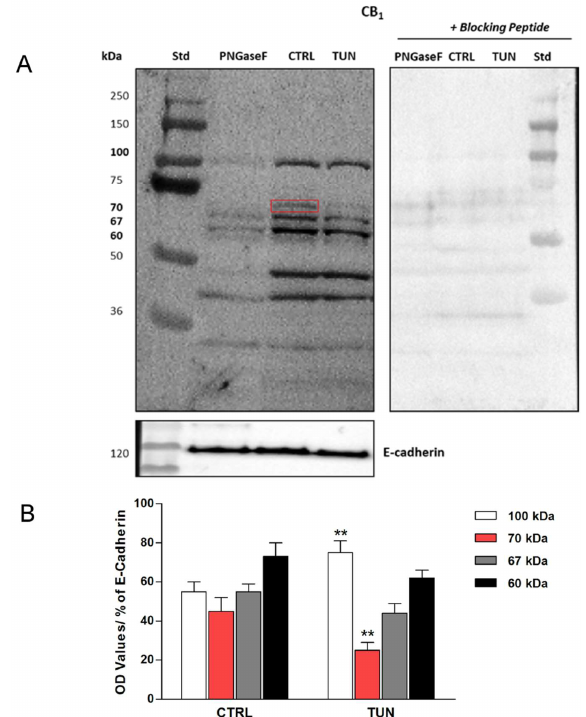
Figure 2. Representative Western blot of tunicamycin effect on cannabinoid receptor 1 (CB 1 ) protein expression. SH-SY5Y cells were treated for 24 h with tunicamycin (TUN 1 µg/mL) and with PNGase F (20 µL of 500 U/mL solution), as indicated. Controls with specific blocking peptides are also shown. The red square indicates the immunoreactive band at 70 kDa, erased by tunicamycin and PNGase F treatments ( A ). Densitometric analysis of CB 1 immunoreactive bands (100 kDa, 70 kDa, 67 kDa and 60 kDa) normalized to E-cadherin content. Data are presented as means ± SEM (n = 3) [** p < 0.01 vs. CTRL] ( B ).